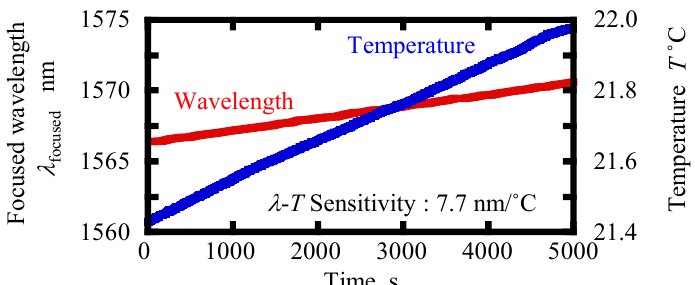
Figure 12. The thermal stability of focused wavelength λ focused of the overall second prototype measurement setup shown in Figure 11b.